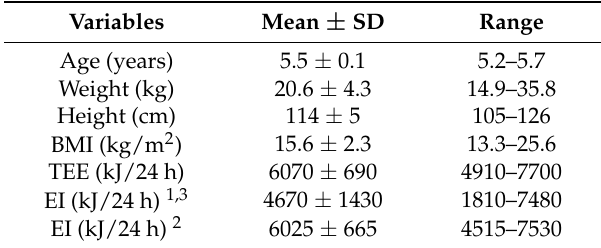
Table 1. Age, weight, height and energy expenditure of the study participants ( n =